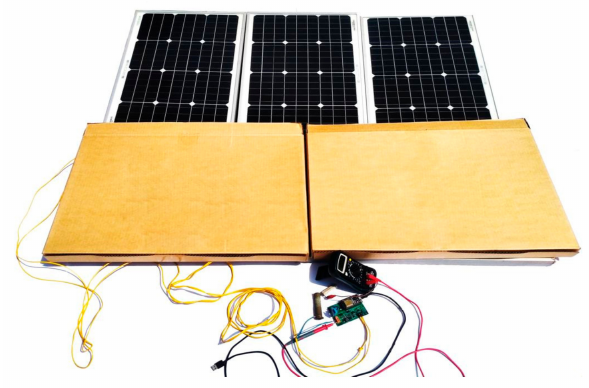
Figure 12. Three active PV modules with two fully shaded.